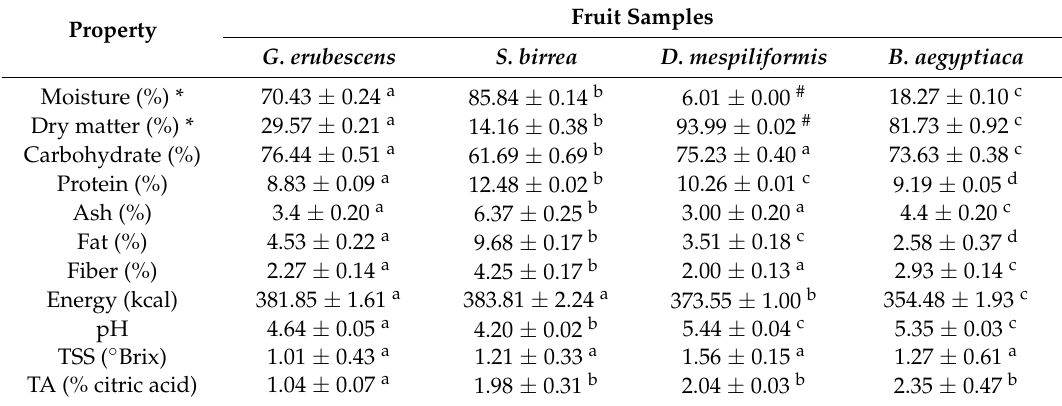
Table 2. Proximate and physicochemical properties of four underutilized forest fruits.